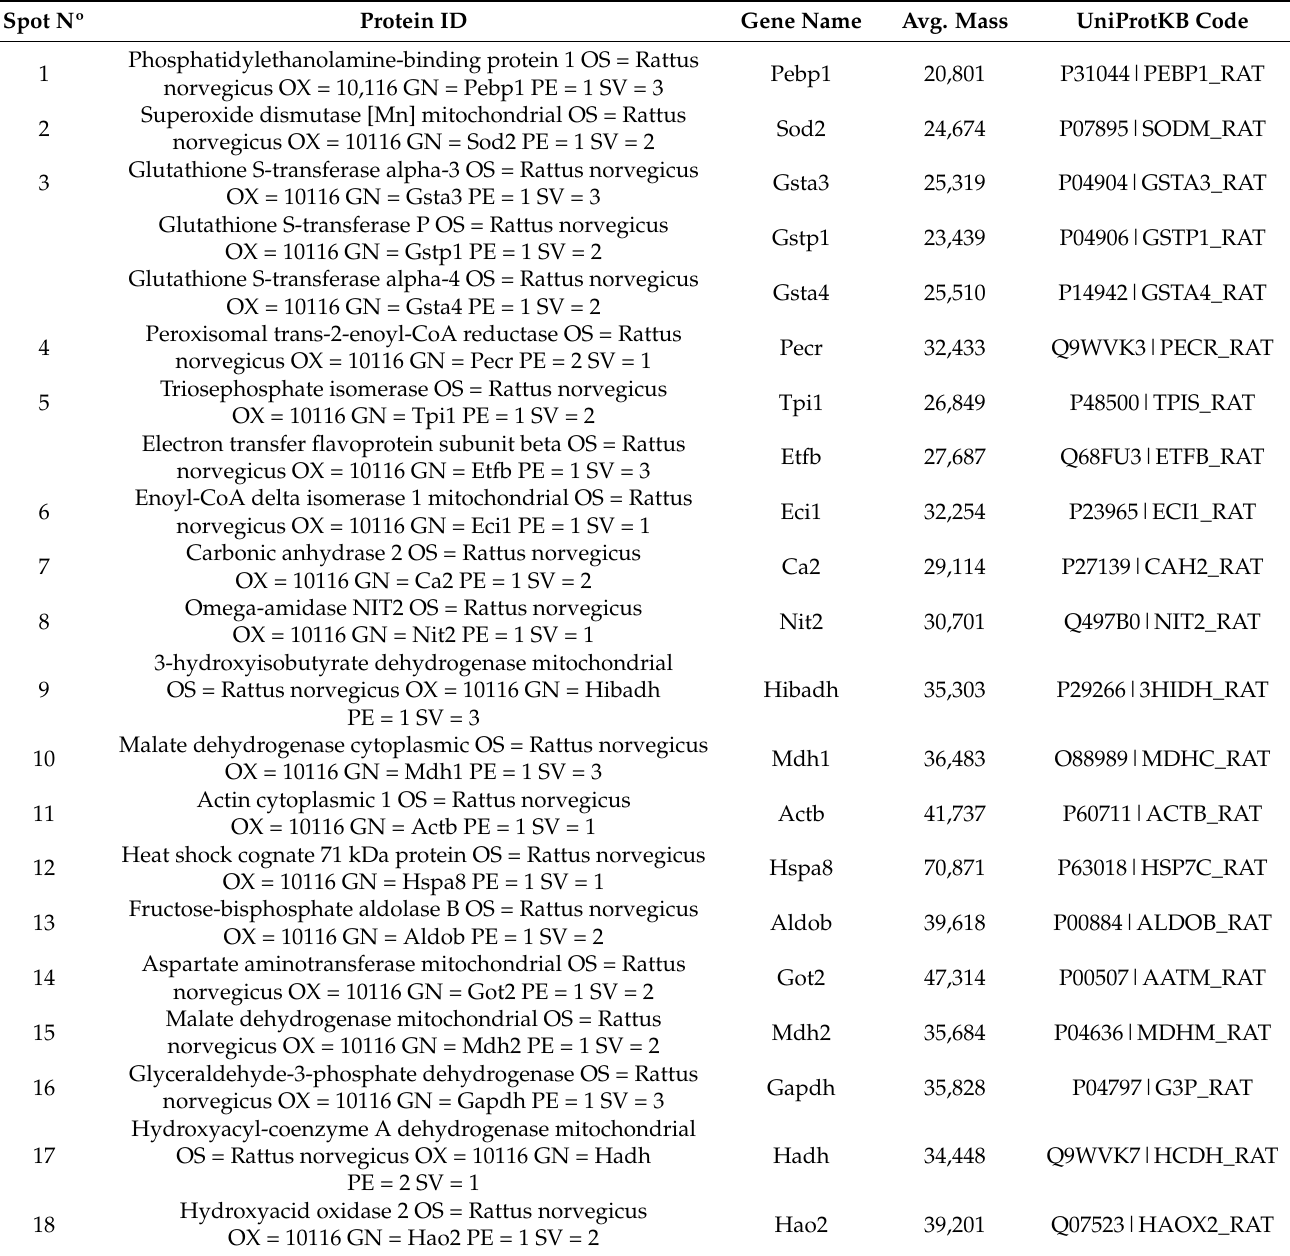
Table 5. Carbonylated proteins identified in the kidney of Sprague Dawley rats. Spot Nº refers to numbered spots on Figure S2. Spots of interest were identified by LC-ESI-IT-MS/MS, as described in the Materials and Methods